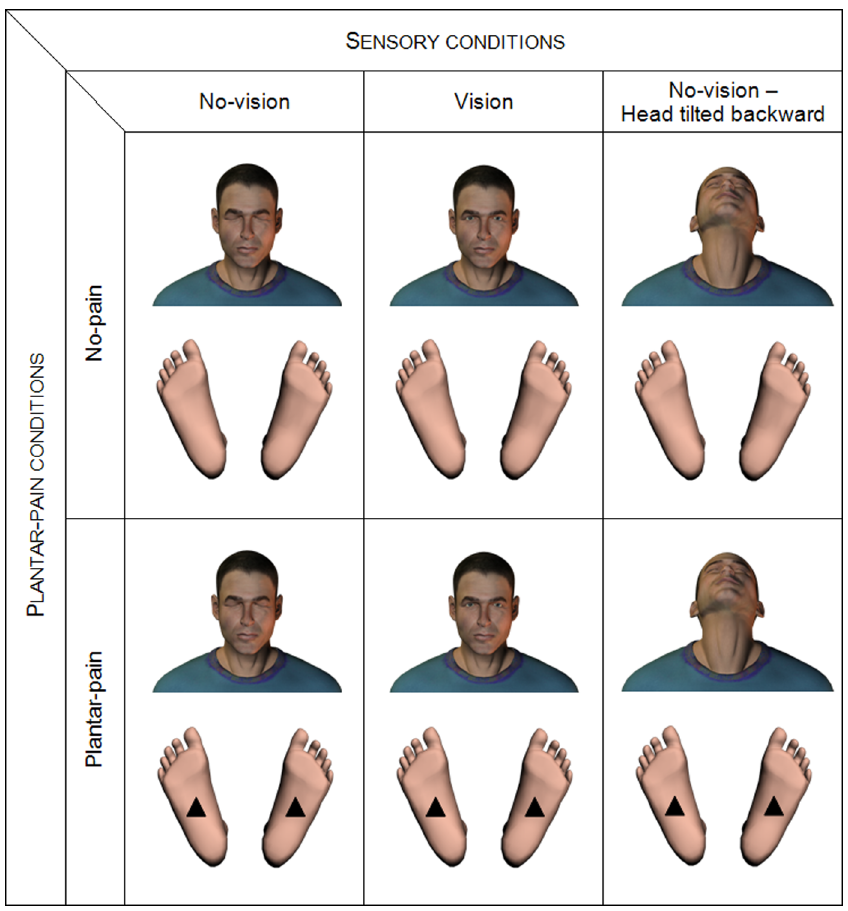
Figure 4. Illustration of the six experimental conditions used the study.